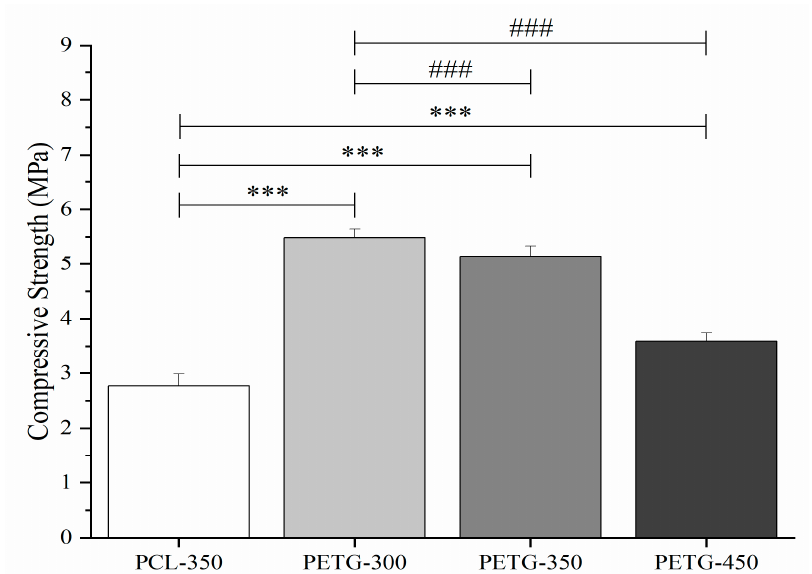
Figure 5. Compression strength values for the PCL sca ff old and PETG sca ff olds with di ff erent pore size. *** p < 0.001 compared with control (PCL), ## p < 0.01 and ### p < 0.001 compared with di ff erent pore size. The *** Statistical evidence ( p < 0.001) is the one-way analysis of the mechanical compression test with the use of GraphPad Prism software and it is used to show the di ff erence be-tween the results. The * is small di ff erence and while more * are added the di ff erences between the results are higher. * compared with PCL sca ff olds, # compared with di ff erent pore size of PETG sca ff olds. Table 3. Compressive mechanical properties.